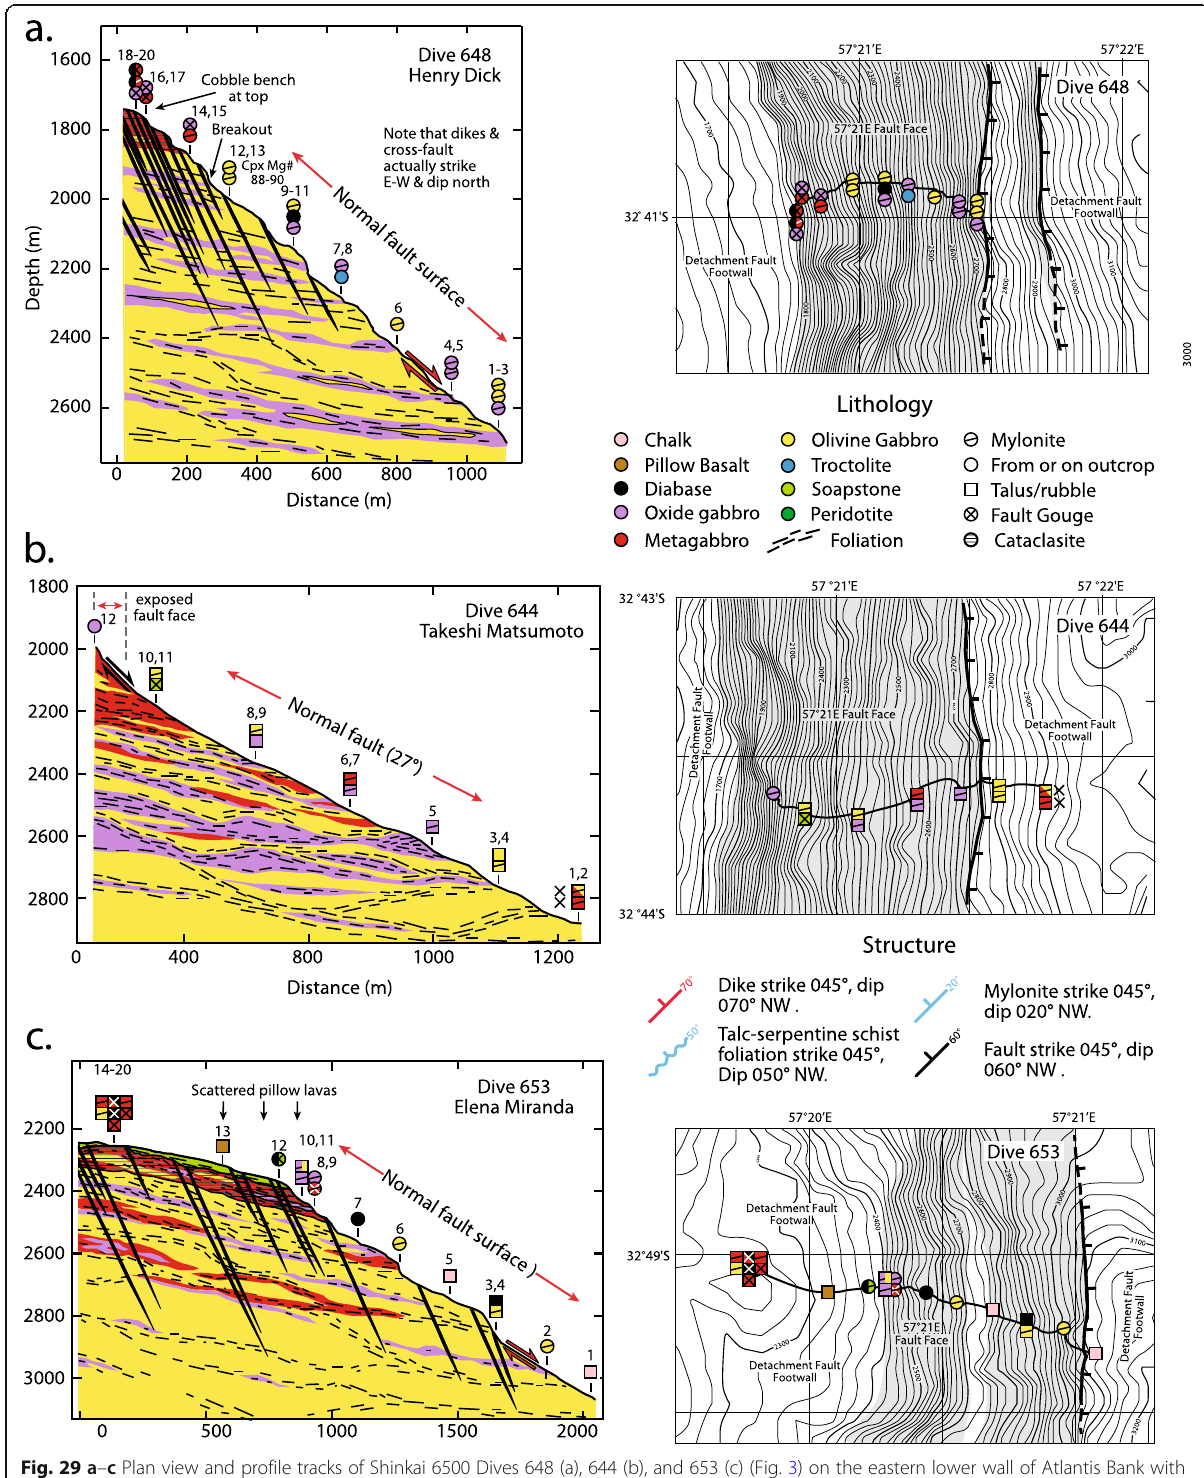
Fig. 29 a – c Plan view and profile tracks of Shinkai 6500 Dives 648 (a), 644 (b), and 653 (c) (Fig. 3) on the eastern lower wall of Atlantis Bank with interpretive cross-sections. Profiles represent distance along track, rather than a straight section. Scientific divers as indicated on the cross-sections. Dikes are shown oriented perpendicular to their actual ~ E-W strike and northerly dip for illustrative purposes. Scientific divers were H. Dick, T. Matsumoto, and E. Miranda as indicated on the left side panels. Approximate area of the high-angle normal fault faces shaded in light gray in the plan views of the